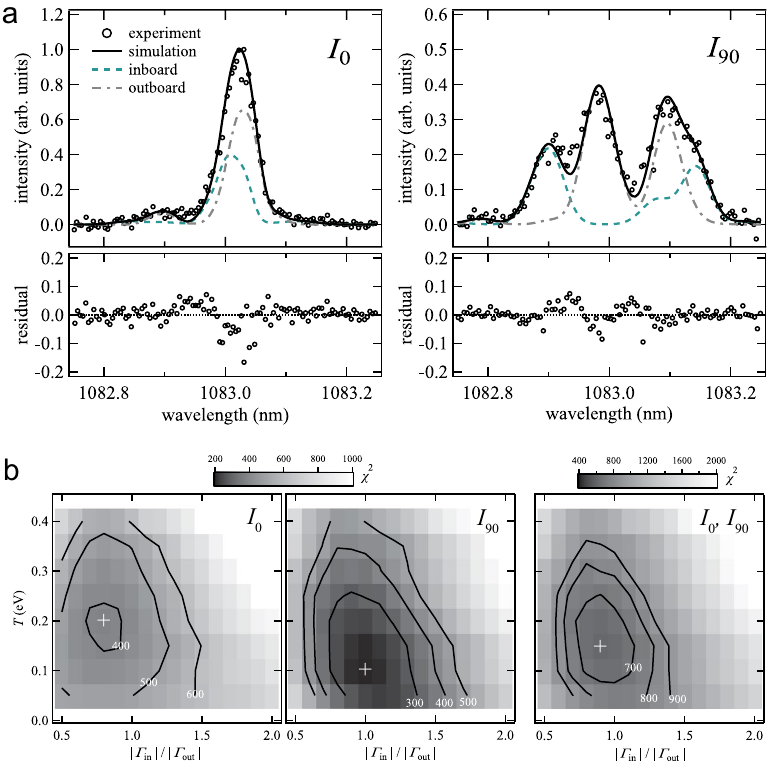
Figure 3. ( a ) I 0 and I 90 of a chord-integrated HeI 2 3 S-2 3 P emission line spectrum averaged over 10 discharges (#80303–312). The lines show the fitted spectra obtained by simulation. ( b ) χ 2 distributions as functions of the parameters T and | Ŵ in /Ŵ out | for fitting to I 0 , I 90 , and both I 0 and I 90 . T and | Ŵ in /Ŵ out | were varied at discrete step sizes of 0.05 eV and 0.1, respectively, and the cross marks show χ 2